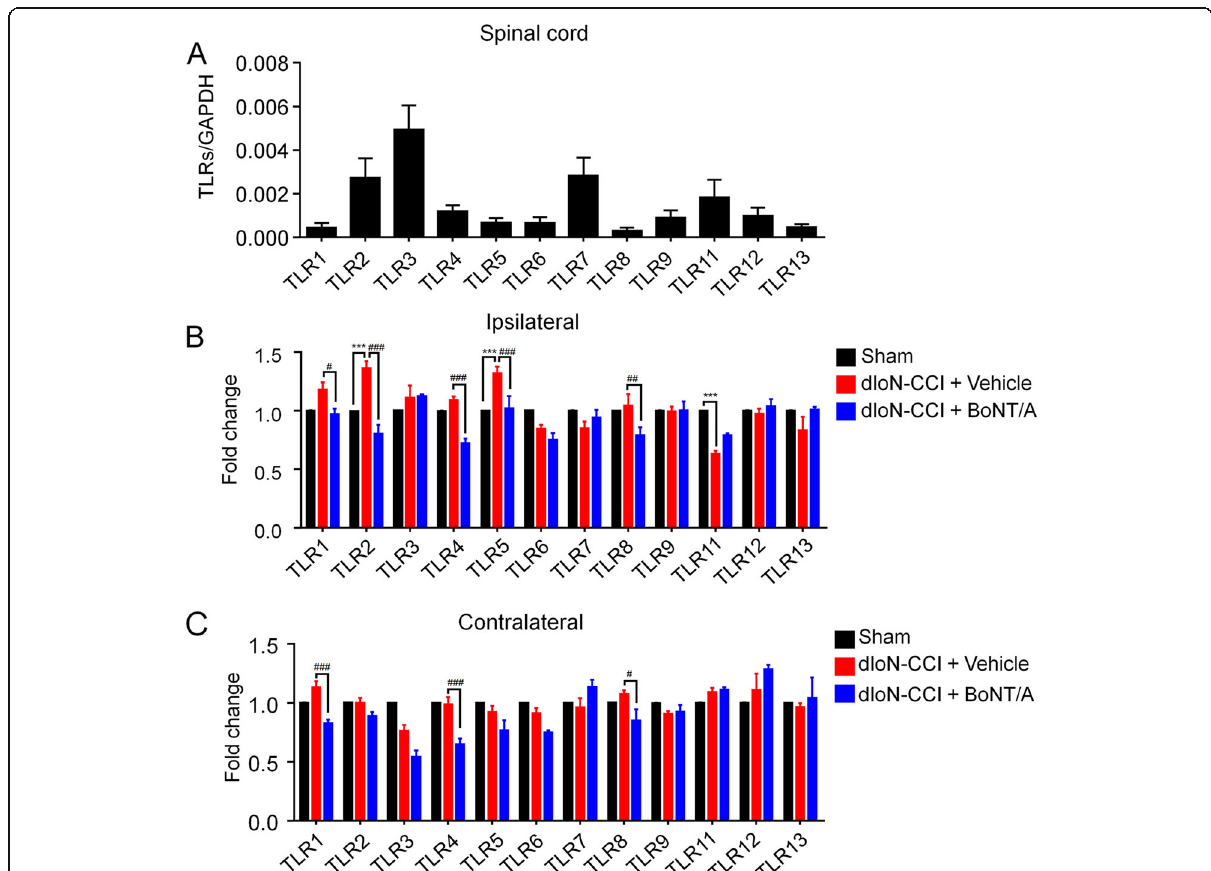
Fig. 4 Expression of TLRs in bilateral TNC using RT-qPCR. a RT-qPCR analyzed the expression levels of TLRs in wild-type mice. GAPDH was used as internal control ( n = 6). b Relative expression of TLRs in the ipsilateral TNC on day 5 after BoNT/A injection (day 19 following dIoN-CCI surgery) among the three groups. There was an increase in TLR2 and TLR5, a decrease in TLR11 in the dIoN-CCI group compared with the sham group, while there was a decrease in TLR1, TLR2, TLR4, TLR5 and TLR8 expression after BoNT/A injection. c Relative expression of TLRs in the contralateral TNC on day 5 after BoNT/A injection (day 19 following dIoN-CCI surgery) among the three groups. The dIoN-CCI and sham group showed no significant change in TLRs expression, while TLR1, TLR4 and TLR8 expression decreased after BoNT/A injection. Data was expressed as Mean ± SEM. ( n = 4 each group, *** P < 0.001 compared with the sham group. # P < 0.05, ## P < 0.01, ### P < 0.001 compared with the dIoN-CCI group, unpaired Student ’ s t-test). TLRs, toll-like receptors; TNC, trigeminal nucleus caudalis; dIoN-CCI, chronic constriction injury of distal infraorbital nerve; BoNT/A, botulinum toxin – A; BL,